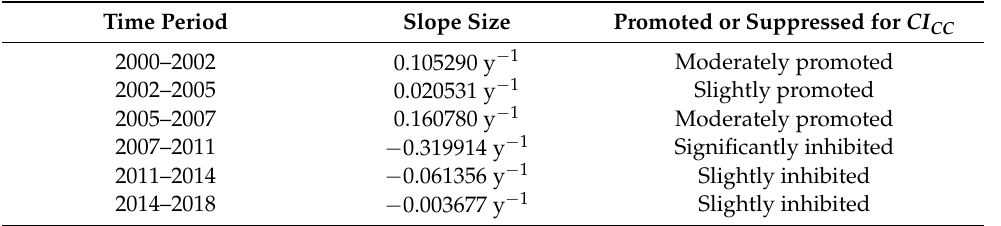
Table 7. Slope values of CI CC in different